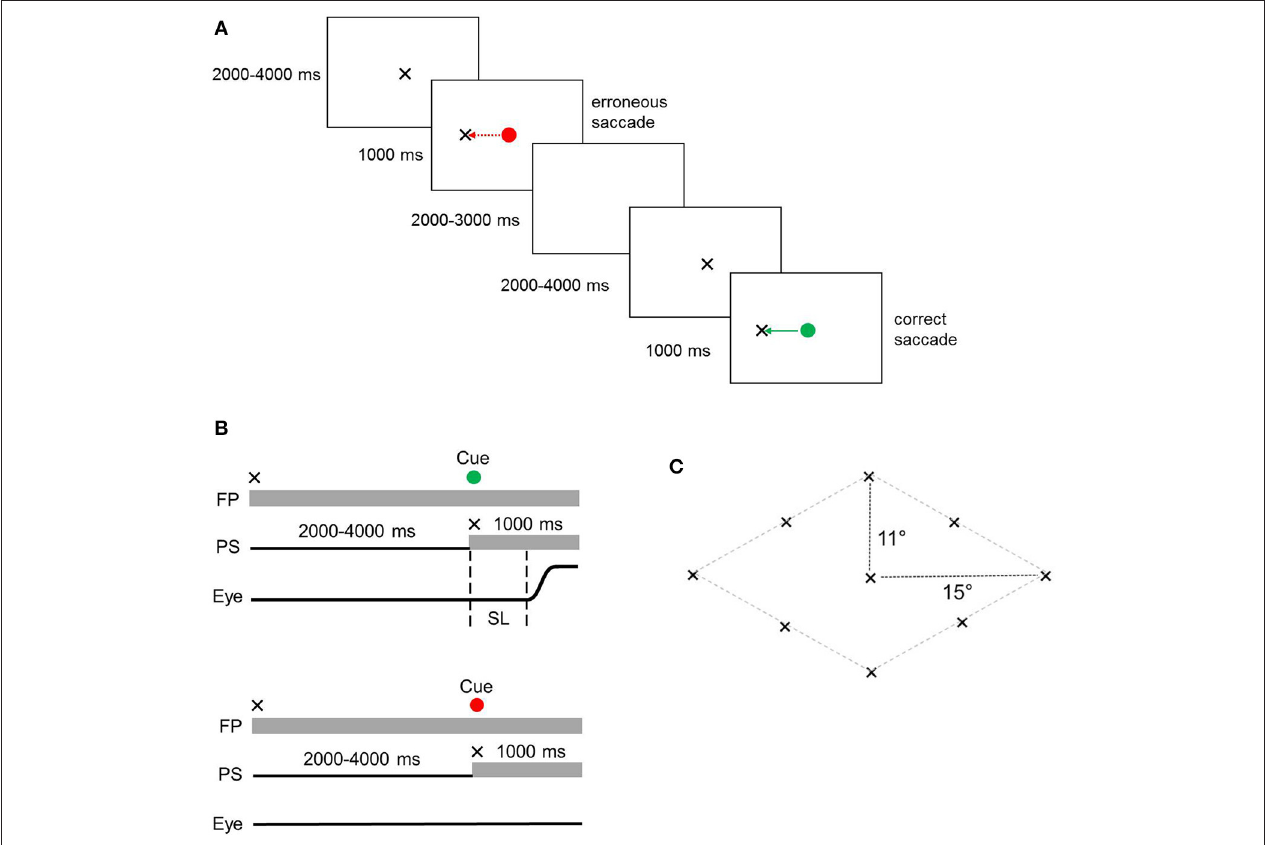
FIGURE 2 | (A) Schematic representation of the Go/NoGo task - Sample trials. The NoGo condition - cue is red; Go condition - cue is green. (B) Go/NoGo task - Temporal sequences of a representative task trial. Upper – Go condition, lower – NoGo condition. FP, fixation point, PS, peripheral stimulus, Eye, schematic eye shift (a saccade), SL, saccade latency. (C) Go/NoGo task - Stimuli locations in the visual